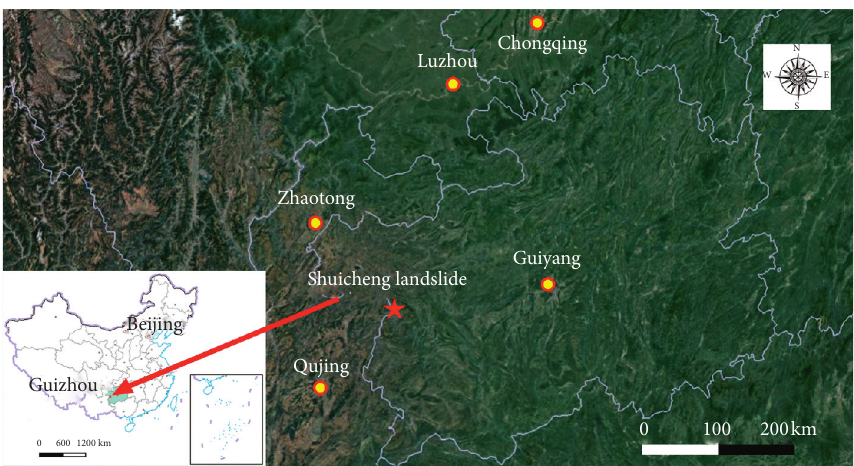
Figure 1: Geographical location of the Shuicheng landslide.